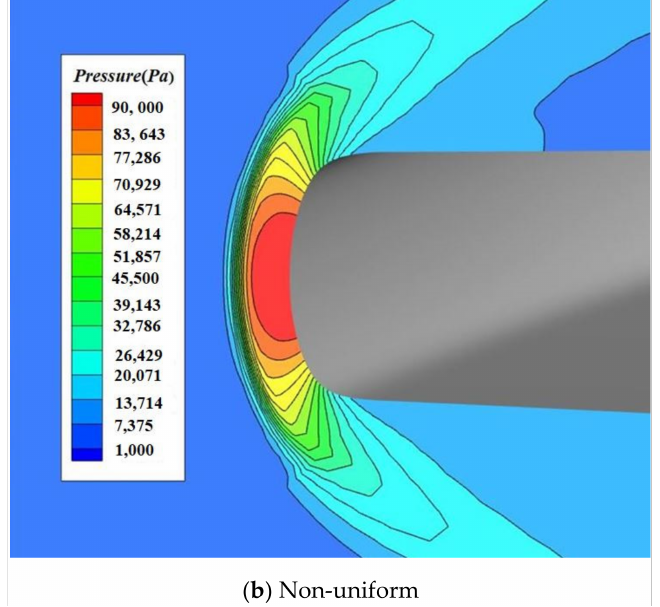
Figure 9. Pressure contour under the symmetry plane of the waverider (diameter/height: 20 mm, units: Pa).